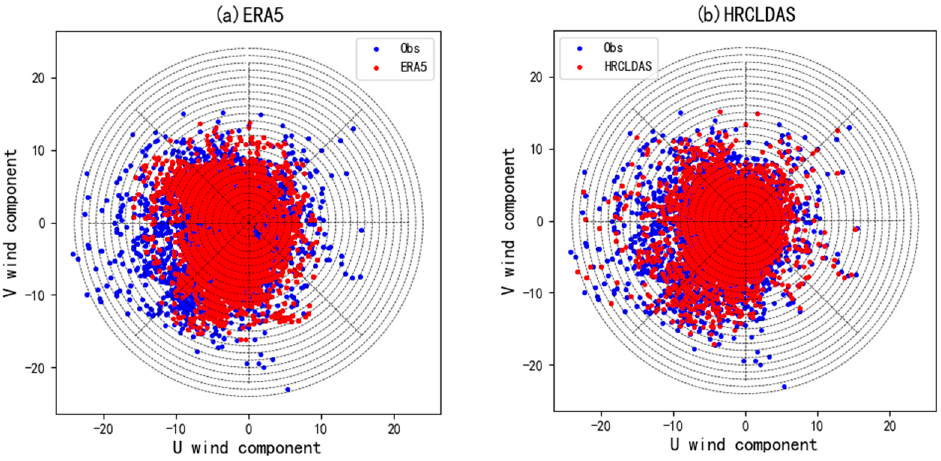
Figure 11. The frequency distribution of wind vector on 12–14 October 2020. ( a ) ERA5; ( b ) HRCLDAS. wind speed with time between the two datasets and the observations during the typhoon. Figure 12a depicts a location map of selected sites, which represent an offshore island station, an offshore land station, a remote island station, and a land station.